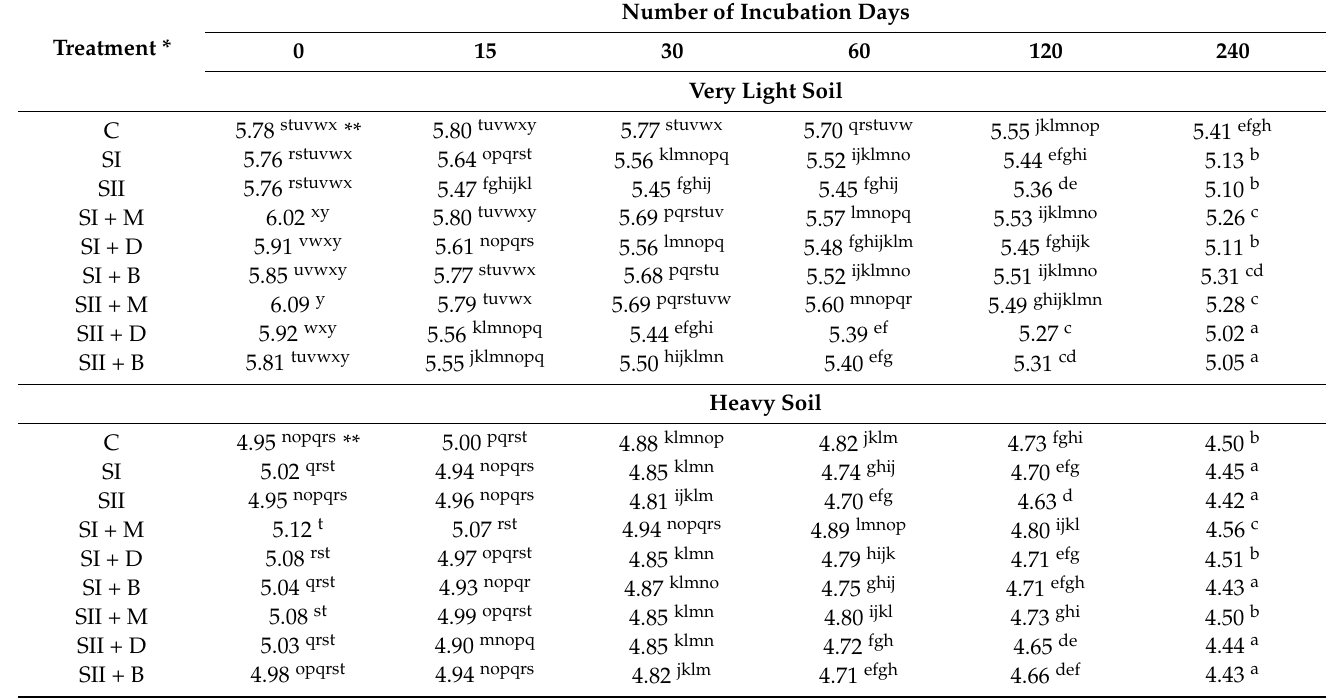
Table 3. Very light and heavy soil pH KCl value throughout the incubation